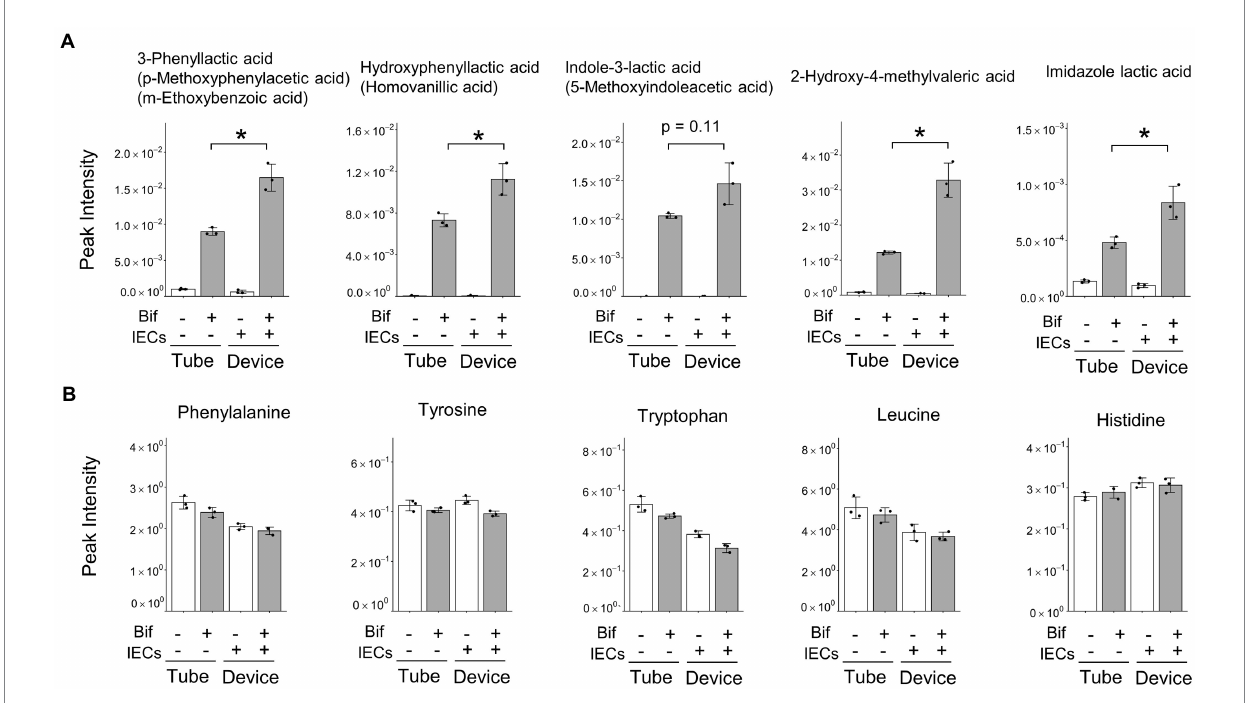
FIGURE 2 Peak intensity of amino acid-derived metabolites and their precursor amino acids. (A) Amino acid-derived metabolites, alternatives are shown in parentheses when peaks were annotated with more than one metabolite. (B) Precursor amino acids corresponding to the five metabolites shown in Figure 3. (A) Data are expressed as the mean ± SD ( n = 3),* p < 0.05, ** p < 0.01 (Welch’s t -test).